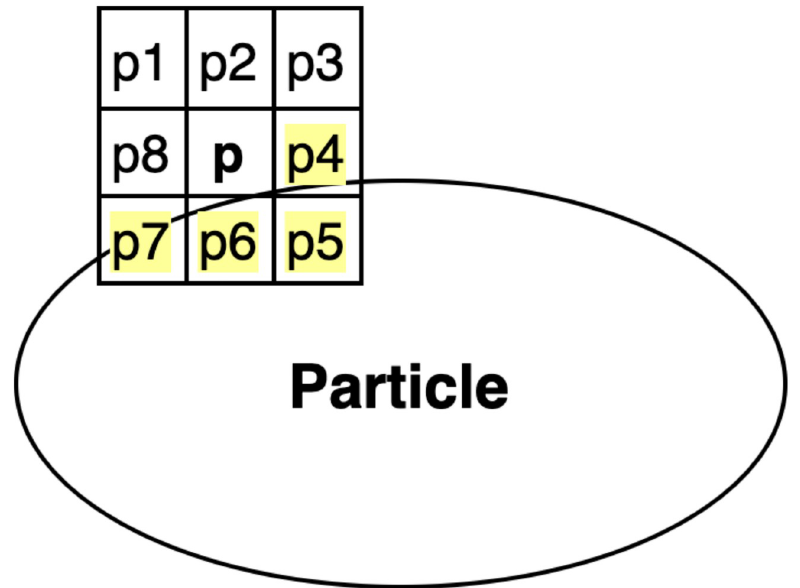
Fig 2. Example of the application of the Moore-neighbor algorithm for particle